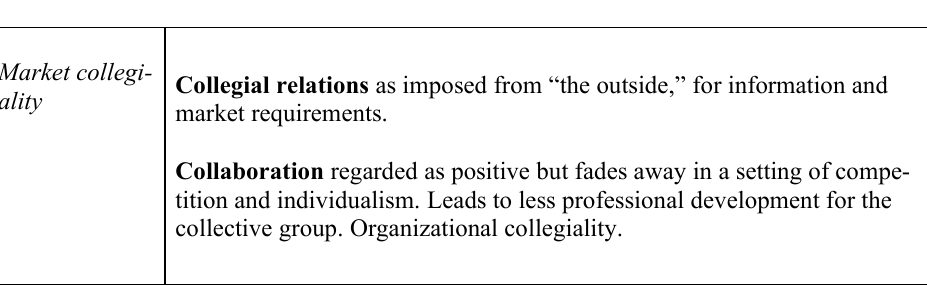
Collegiality as ideal types in the framework of institutional logics (Freidson, 2001) Ideal types of collegiality in terms of collegial relations and collaboration Market collegi-